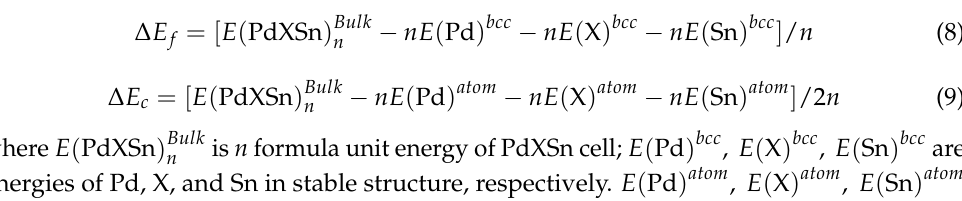
Molecules 2022 , 27 , x FOR PEER REVIEW 4 of 14 Table 2. Optimized lattice parameters of PdXSn (X = Zr, Hf) compound. Parameter Lattice Constant (